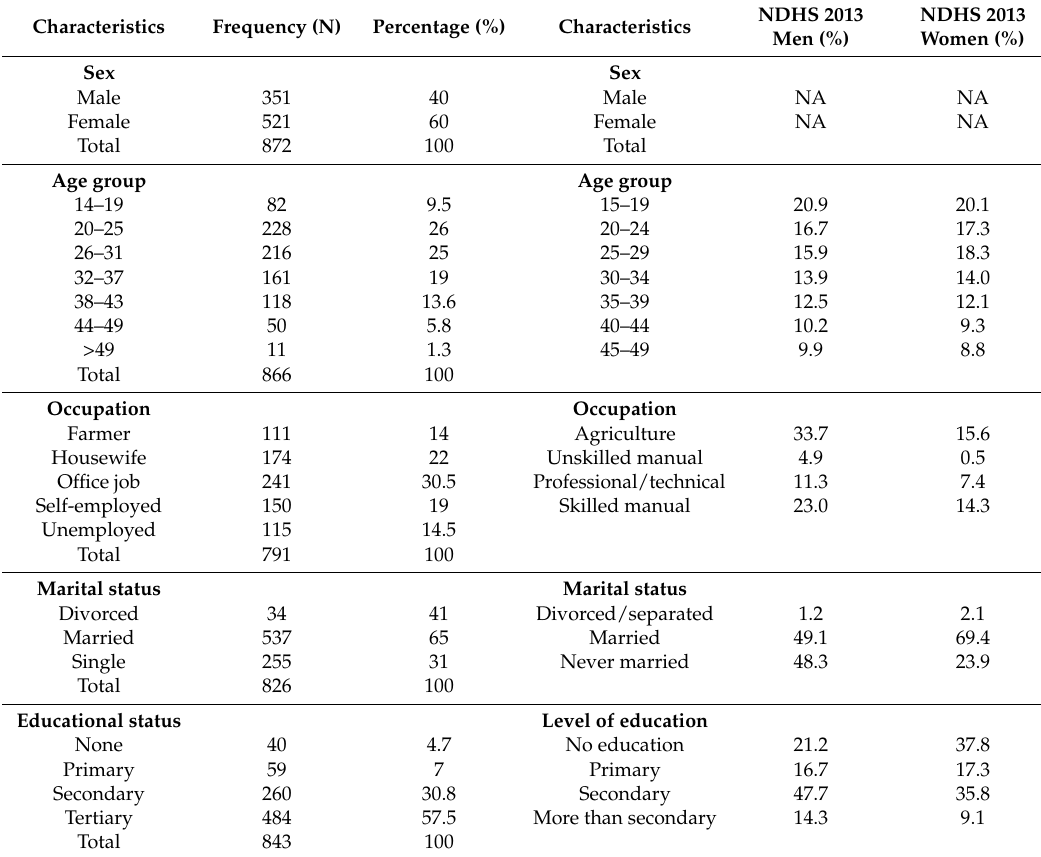
Table 2. Characteristics of community